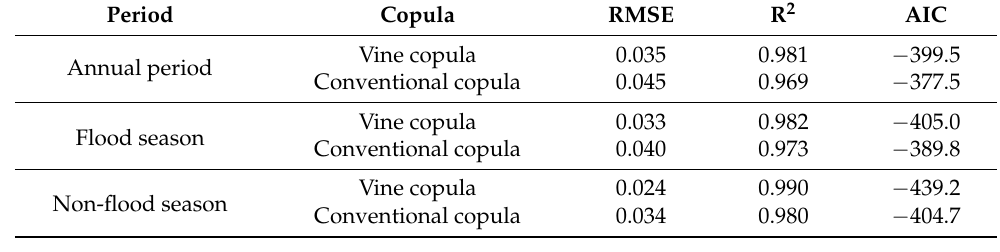
Table 13. The RMSE values, R 2 values, and AIC values of results obtained by the conventional copula function and the vine copula function.